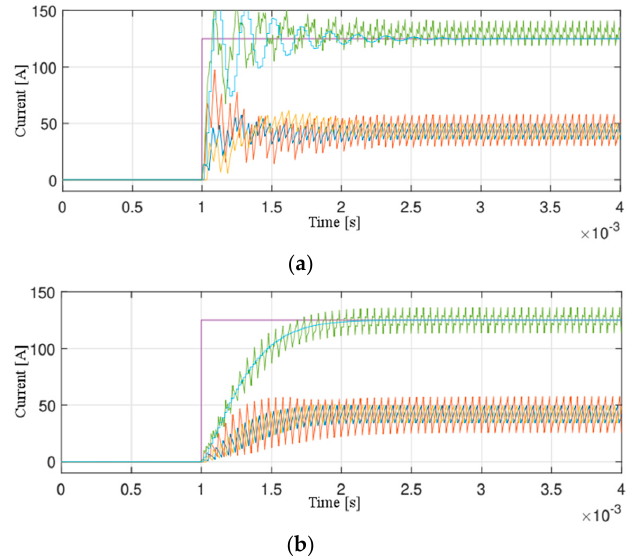
Figure 13. Total (green), total sampled (light blue), reference (violet), and inductors (blue, yellow, and red) currents under 50% inductance parameter variation (on the red leg) with the method proposed in [13] ( a ) and with the method proposed in this paper ( b ).